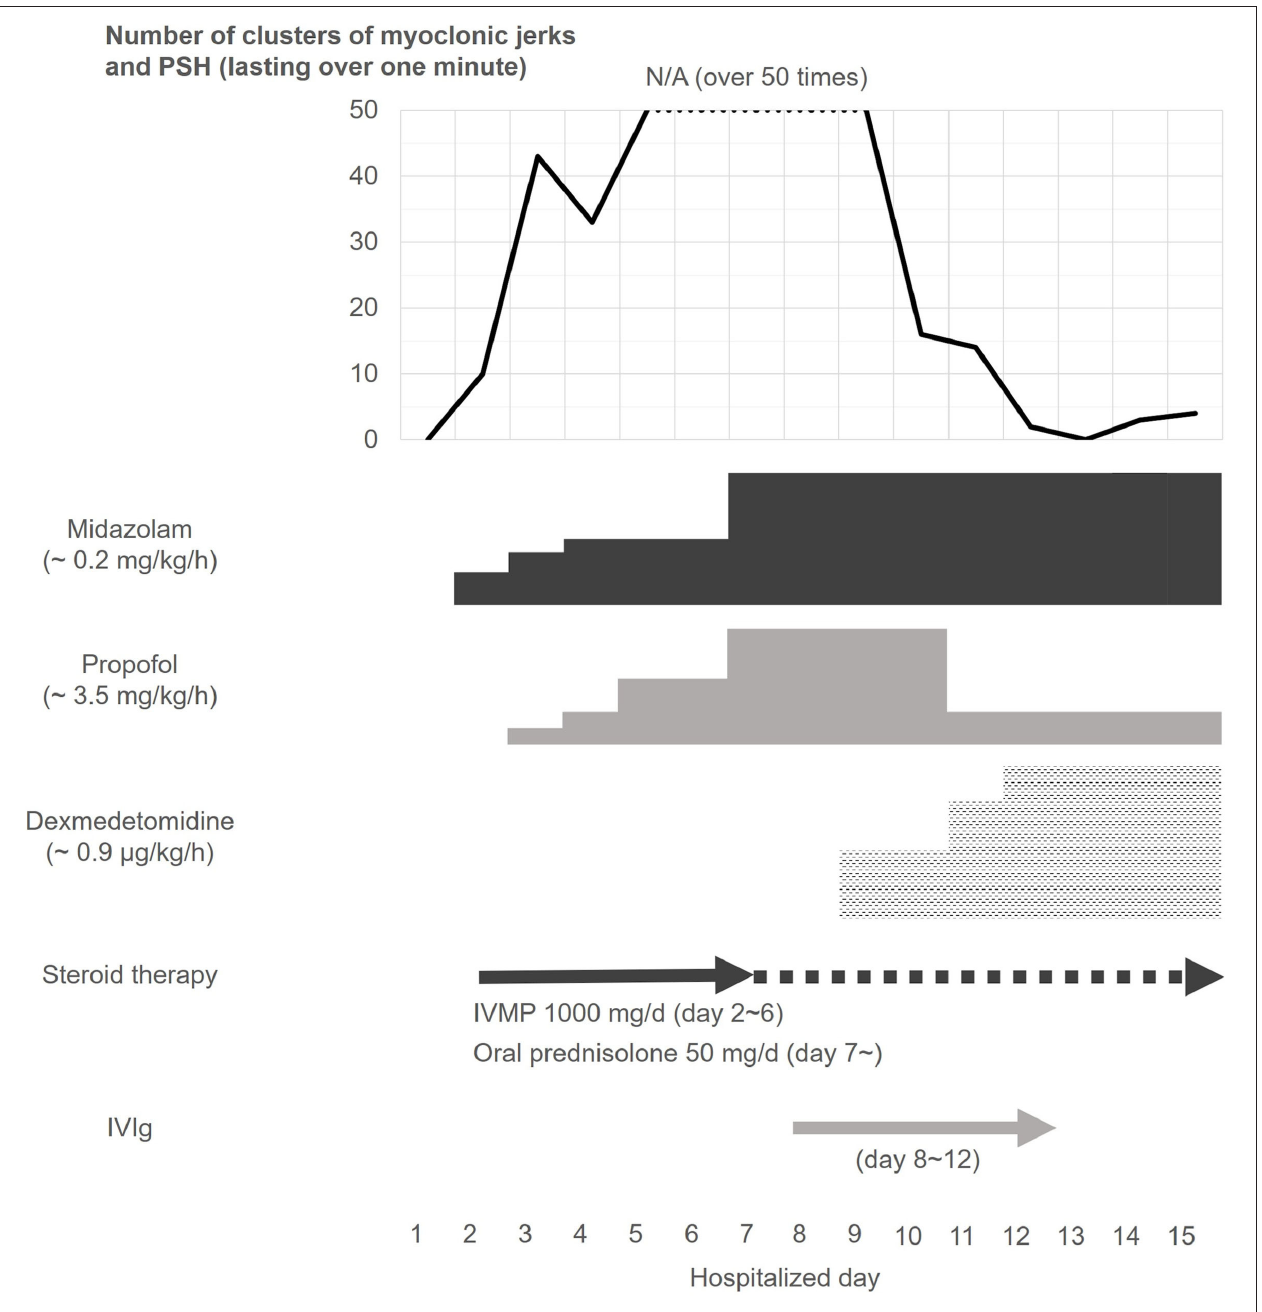
FIGURE 2 | Clinical course of clusters of myoclonic jerks and paroxysmal sympathetic hyperactivity. Despite continuous infusion of midazolam and propofol, the patient frequently developed severe clusters of myoclonic jerks and PSH. The patient was also treated with a 5-day course of IVMP from day 2, and IVIg from day 8 of admission, but the clusters did not respond to the GABAergic agents and immunotherapy. However, the frequency of the clusters rapidly declined after dexmedetomidine treatment, which was started from day 9 of admission. After that, the episodic symptoms were controlled during the remainder of his hospitalization (see text). IVIg, intravenous immunoglobulin; IVMP, intravenous high-dose methylprednisolone; PSH, paroxysmal sympathetic